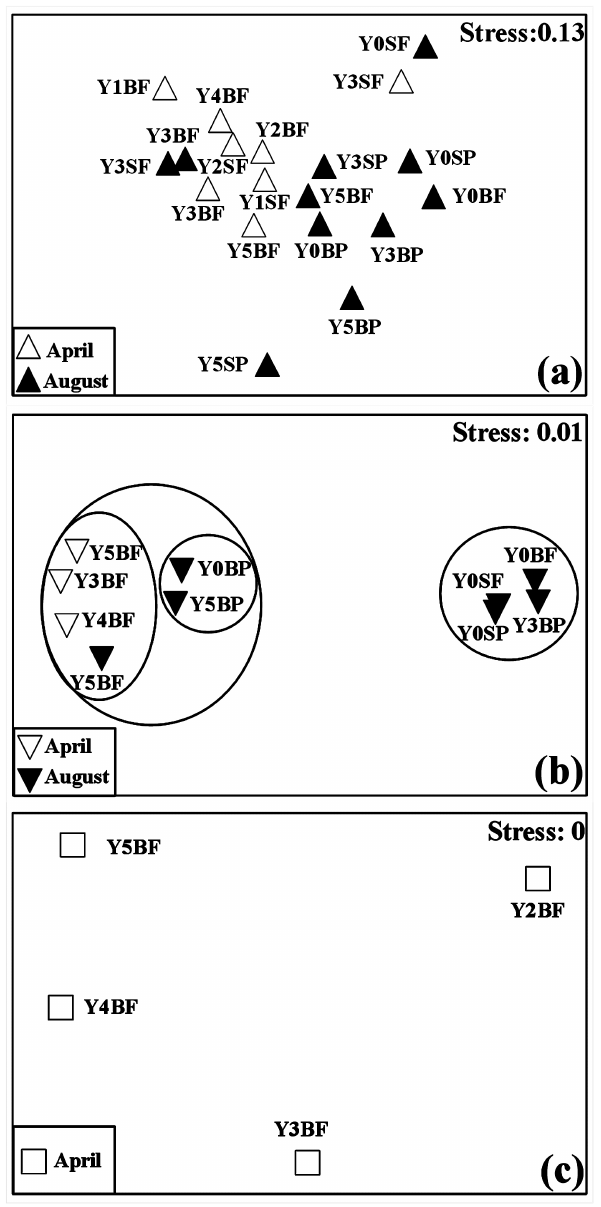
Fig. 6. NMDS ordination based on Bray–Curtis similarities between β -AOB amoA -type nitrifying (a) , AOA amoA -type nitrifying (b) or nirS -type denitrifying communities (c) . Each symbol represents an individual sample in the NMDS charts.